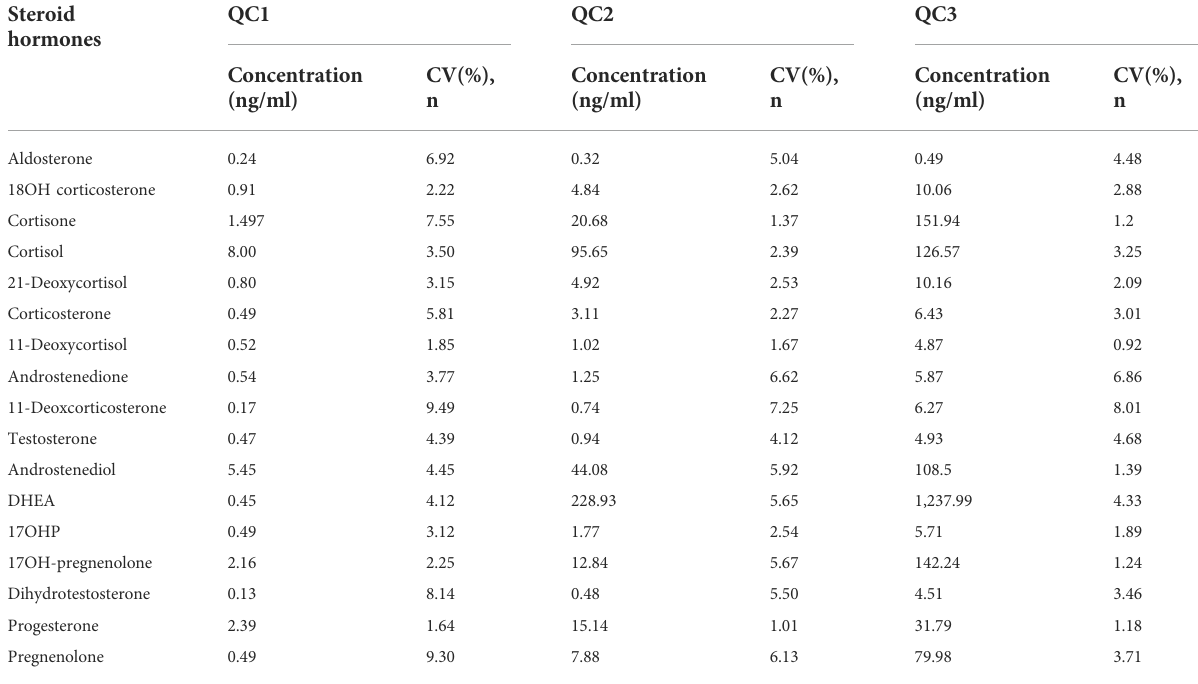
TABLE 4 Total imprecision for each steroid hormone. Steroid hormones